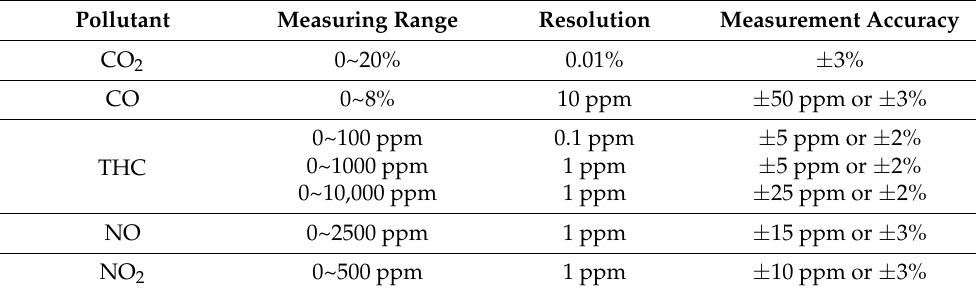
Table 1. Performance parameters of